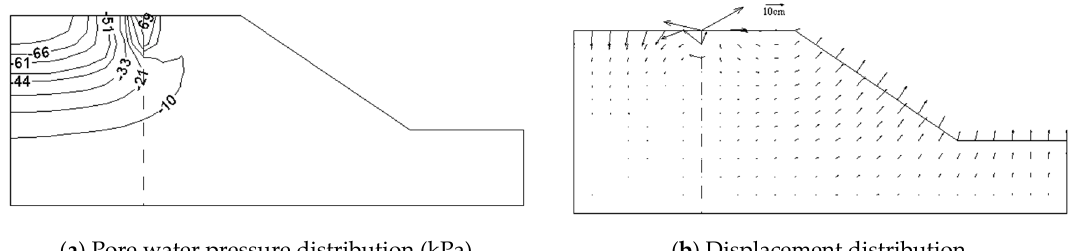
infiltration rate of 0.8 mm/day.